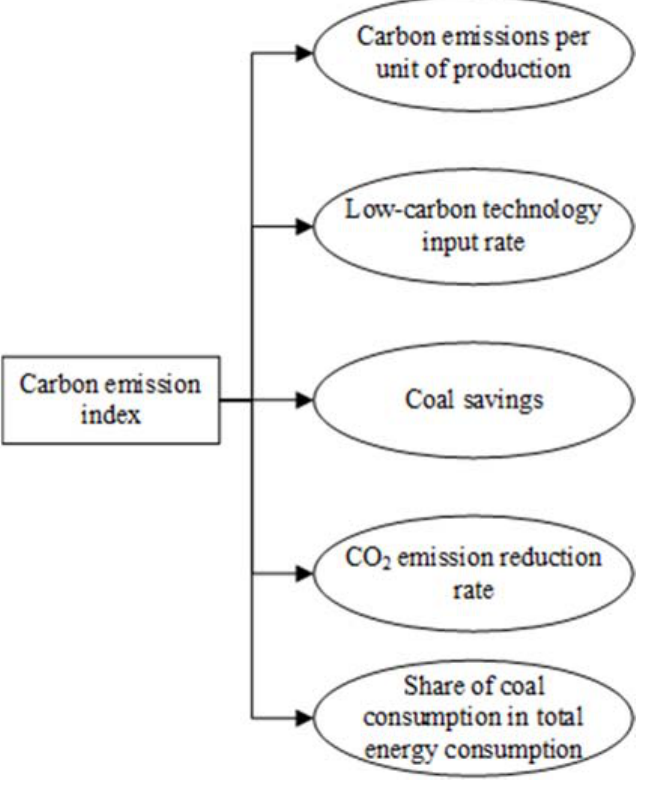
Figure 2. Carbon emission index.